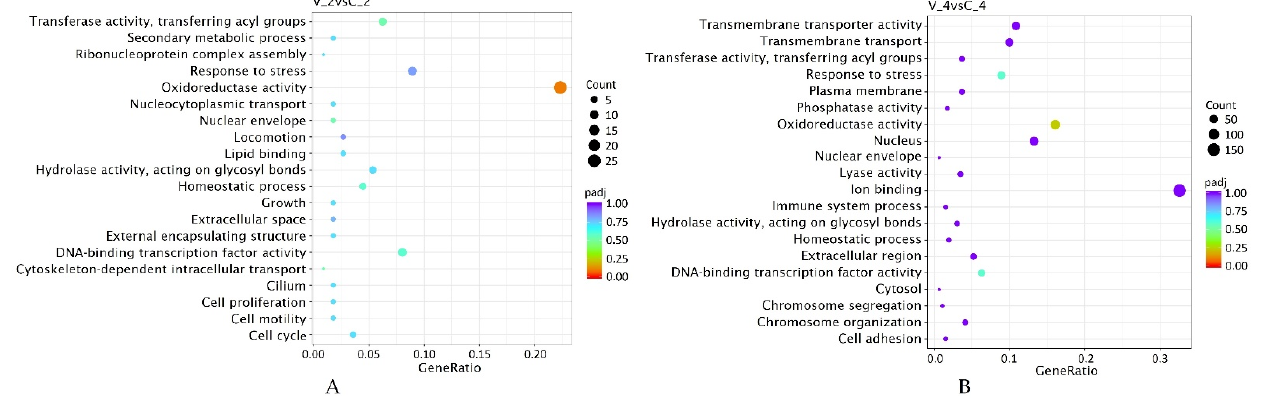
Figure 5. Enriched gene pathways identified according to GO involving differentially expressed genes (DEGs) following biotic stress (virus) inoculation at 2 ( A ) and 4 dpi ( B ) in R. nigrum cv. Aldoniai.